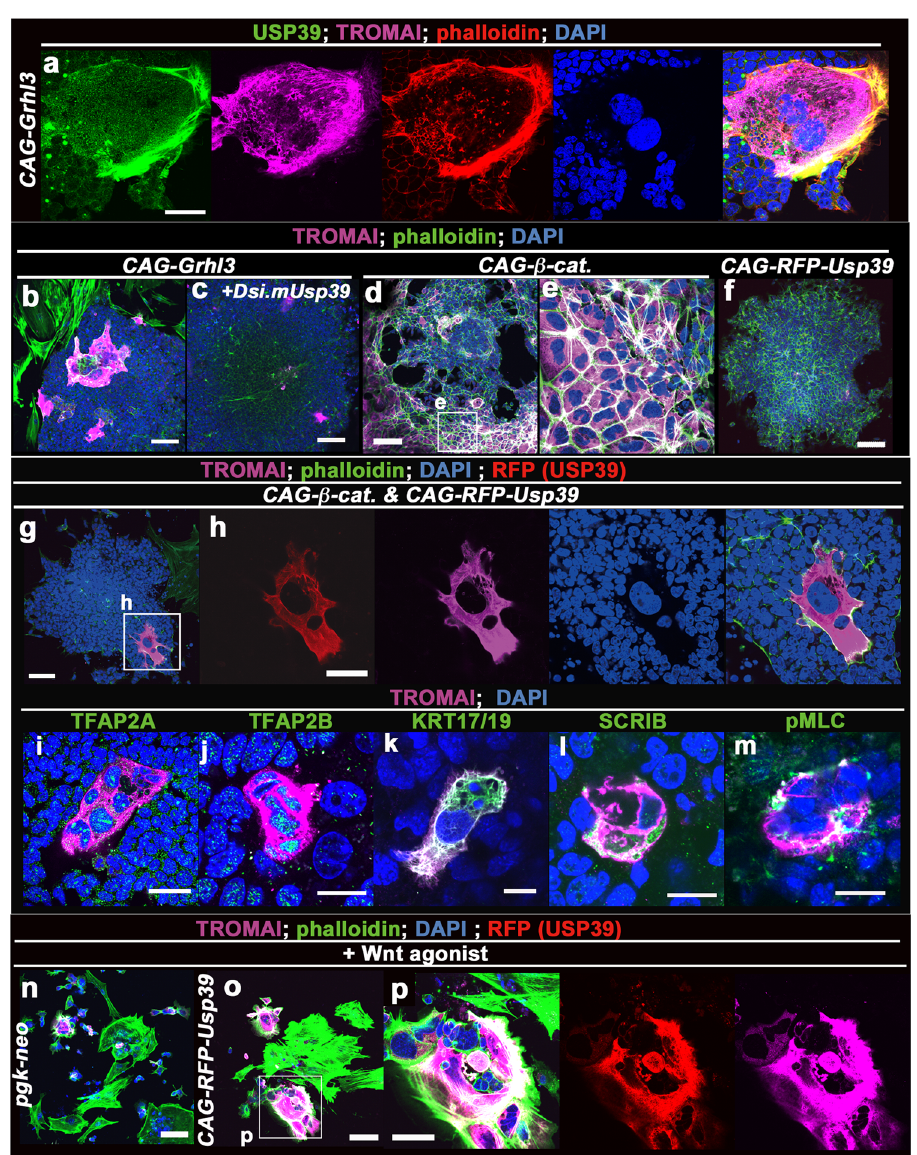
Fig. 3 USP39 promotes formation of LM-epidermal cells by activating non-canonical Wnt signaling. a Immuno fl uorescence staining for ubiquitin-speci fi c protease 39 (USP39; green), cytokeratin 8 (TROMA-1 clone, magenta), phalloidin (F-actin, red), and 4,6 ′ -diamidino-2-phenylindole DAPI (blue) in a large and mature (LM)-epidermal cell. USP39 protein was localized in the cytokeratin- and F-actin – enriched cytoplasmic region of the LM-epidermal cell induced by CAG-Grhl3 from an embryoid body (EB). b , c Embryonic stem (ES) cells were transfected with CAG-Grhl3 alone ( b ), and CAG-Grhl3 and Dicer-substrate small interfering (Dsi)RNA of Usp39 ( c ). Anti-cytokeratin 8 (TROMA-1; magenta), phalloidin (green) and DAPI (blue). EB cells transfected with CAG-Grhl3 induce LM-epidermal cells ( b 100% n = 30). In contrast, EB cells transfected with CAG-Grhl3 treated with Dicer-substrate siRNA of Usp39 decreased the rate of induction of LM-epidermal cells ( c 70% n = 20). d – p Activation of the canonical Wnt pathway together with USP39 can induce LM-epidermal cells. Transfection of CAG- β -catenin S37A (constitutive active form of β - catenin) ( d , e ), CAG – RFP-Usp39 ( f , o , p ), both CAG- β -catenin S37A and CAG-RFP-Usp39 ( g – m ), and pgk-neo ( n ) with Wnt agonist ( n , o , p ). Molecular characterization of LM-epidermal cells induced by the co-transfection of CAG-RFP-Usp39 and CAG- β -catenin S37A plasmids with immunohistochemistry ( i – m ). TFAP2A ( i ; green), TFAP2B ( j ; green), keratin (KRT)17/19 ( k green), SCRIB ( l green) and a phosphorylated form of non-muscle myosin light chain (pMLC)( m green). TFAP2A and TFAP2B, two epidermal markers, and KRT17/19, a mature epidermal marker, were expressed in the LM-epidermal cells. Immuno fl uorescence of SCRIB ( l ) and pMLC ( m ) two non-canonical Wnt markers localized in the cytoplasm of LM-epidermal cells. Cytokeratin-8 (TROMA-1; magenta), phalloidin (green), RFP (red), and DAPI (blue). Scale bars represent 20 μ